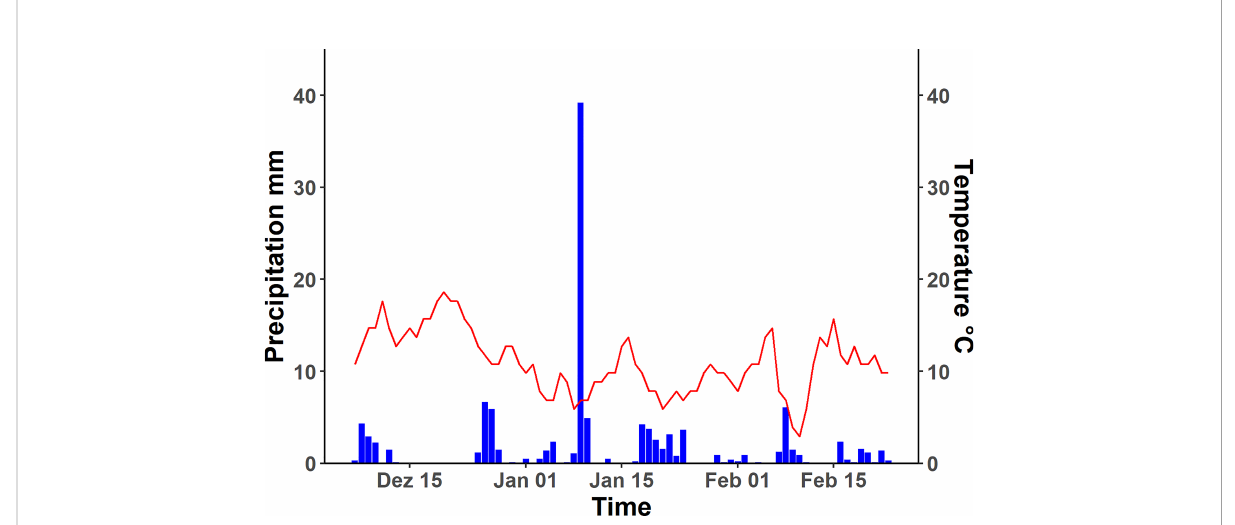
FIGURE 3 Average daily temperature and precipitation of Tulkarm over the growth period of plants used for experiment. Left y-axis shows the precipitation in millimetre, indicated by the blue bars, on the right side the temperature is given in degree Celsius, plotted in the graph as red line. The growth started at 07.12.2019 and ended with the harvest at